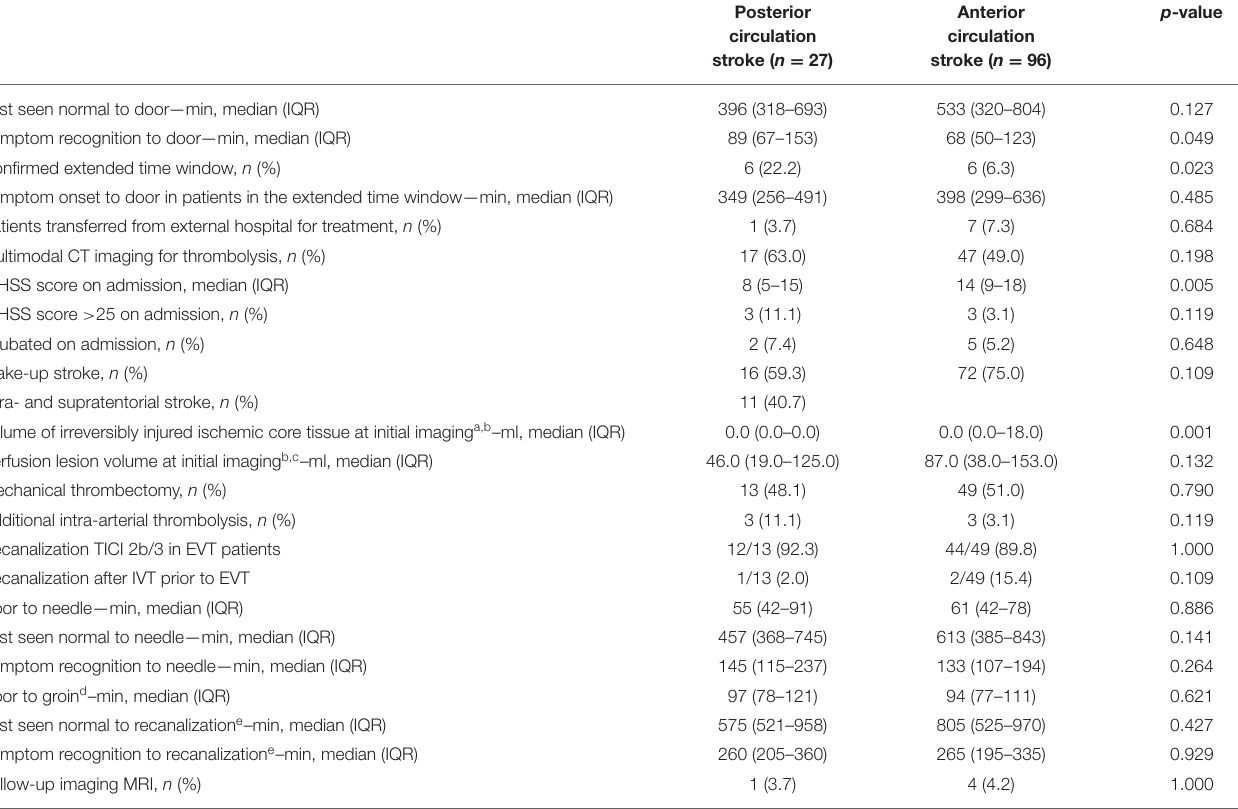
TABLE 6 | Clinical and imaging characteristics of stroke in the large vessel occlusion patient